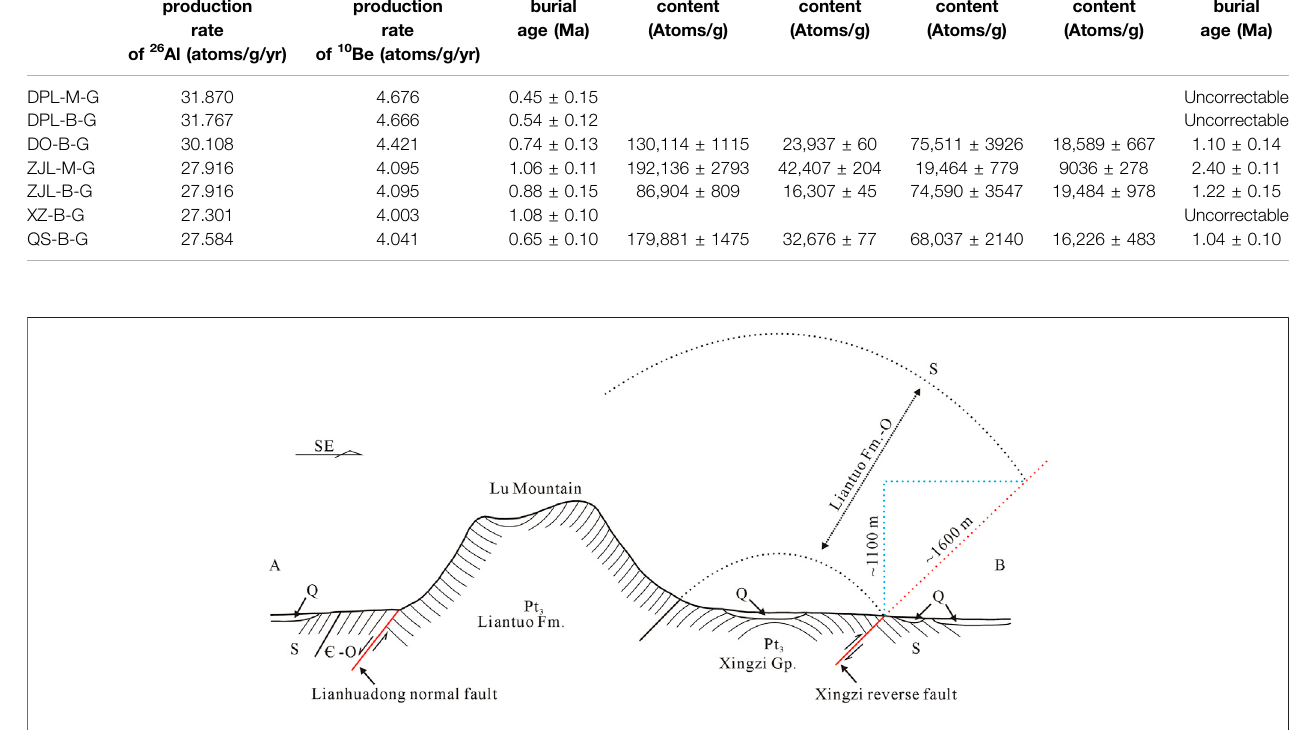
FIGURE 7 | A geologic cross-section not in scale showing the extrusion structure. The Xingzi Group occupies the anticlinal core. The approximate displacement of the Xingzi reverse fault can be estimated from the stratigraphic thicknesses from the Liantuo Formation to the Ordovician. Line A-B indicates the position of the cross-section.